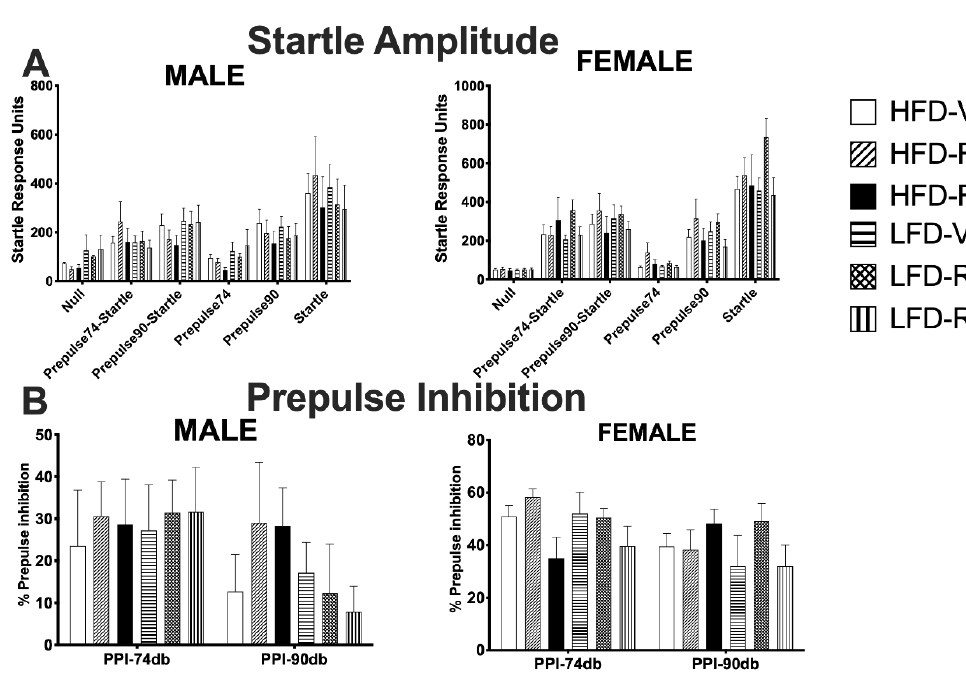
Figure 5. Pre-pulse inhibition of an acoustic startle response behavior test. Pre-pulse inhibition tests were performed during days 21–22 of daily dosing and diet access. Data are represented as means ± standard error of the mean (SEM). High-fat diet (45% fat; HFD, solid lines) and low-fat diet (10% fat; LFD, stripped line) and oral dosed with raspberry ketone (RK) or vehicle (50% propylene glycol, 40% water, and 10% dimethyl sulfoxide; DMSO). Comparisons are separate within each sex. ( A ): Startle amplitude, ( B ) : pre-pulse inhibition. HFD-Vehicle (males: n = 15, females n = 8), HFD-RK (200 mg / kg) (males: n = 7, females: n = 8), HFD-RK (400 mg / kg) (males: n = 8, females: n = 7), LFD-Vehicle (males: n = 16, females: n = 8) LFD-RK (200 mg / kg)(males: n = 8, females: n = 8), and LFD-RK (400 mg / kg)(males: n = 8, females: n = 8).